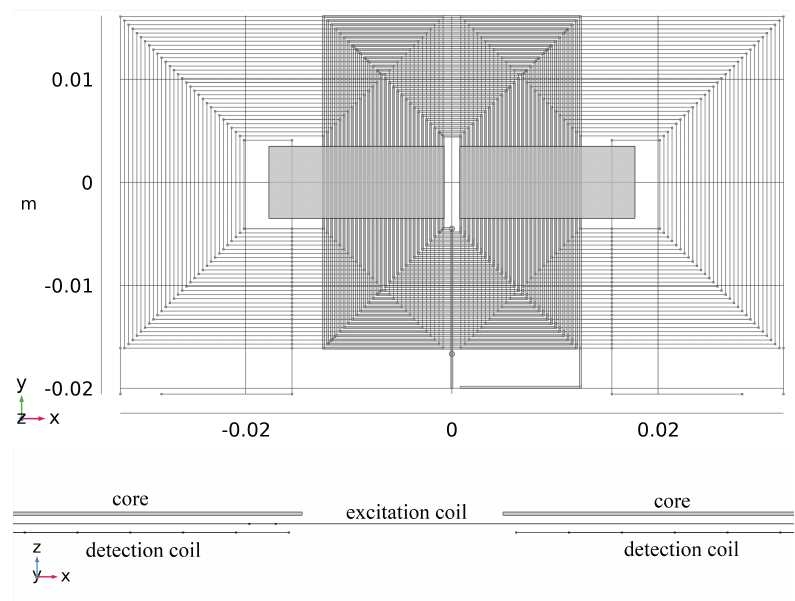
Figure 7. Implemented geometrical model reproducing the PCFS type sensor described in [33] Copyright 2022 IEEE Transactions on Instrumentation and Measurement; top view on the top and zoomed side view at the bottom of the